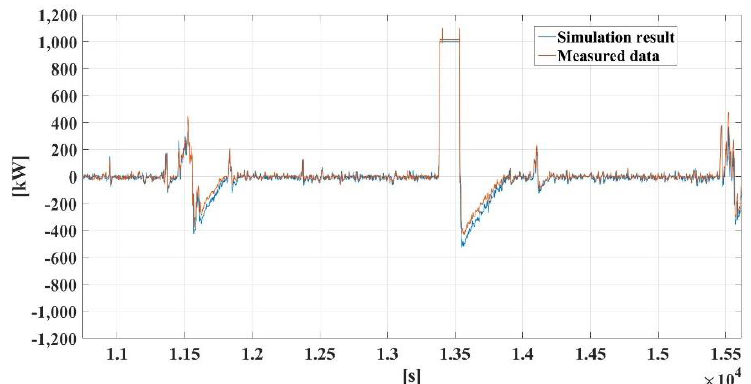
Figure 22. Field test and simulation results: output powers of ESS.